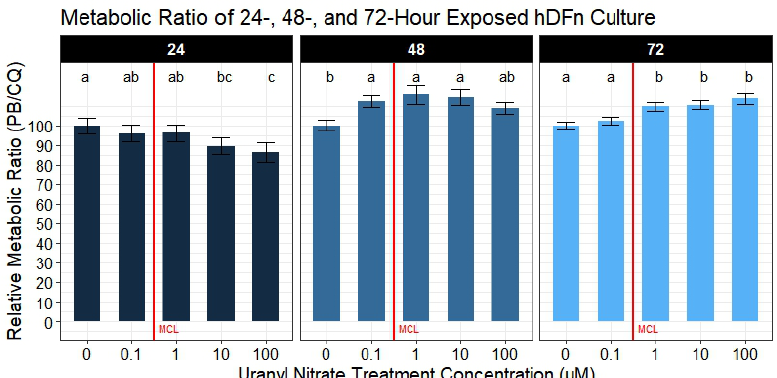
Figure 3. Metabolic ratio of UN exposed hDFn. Bar charts represents the mean relative metabolic ratio percentage ± StdErr of each treatment group (n = 6 done in sextuplicate for each condition). All UN concentrations are in µ M with -0- representing control group. Statistically significant differences between groups are illustrated by compact letter display with different letters at the top representing a balanced Tukey pairwise t -tests where p -value ≤ 0.05. Group means followed by a common letter were not different at 5% level of significance. Vertical red line illustrates the EPA MCL threshold for uranium (0.126 µ